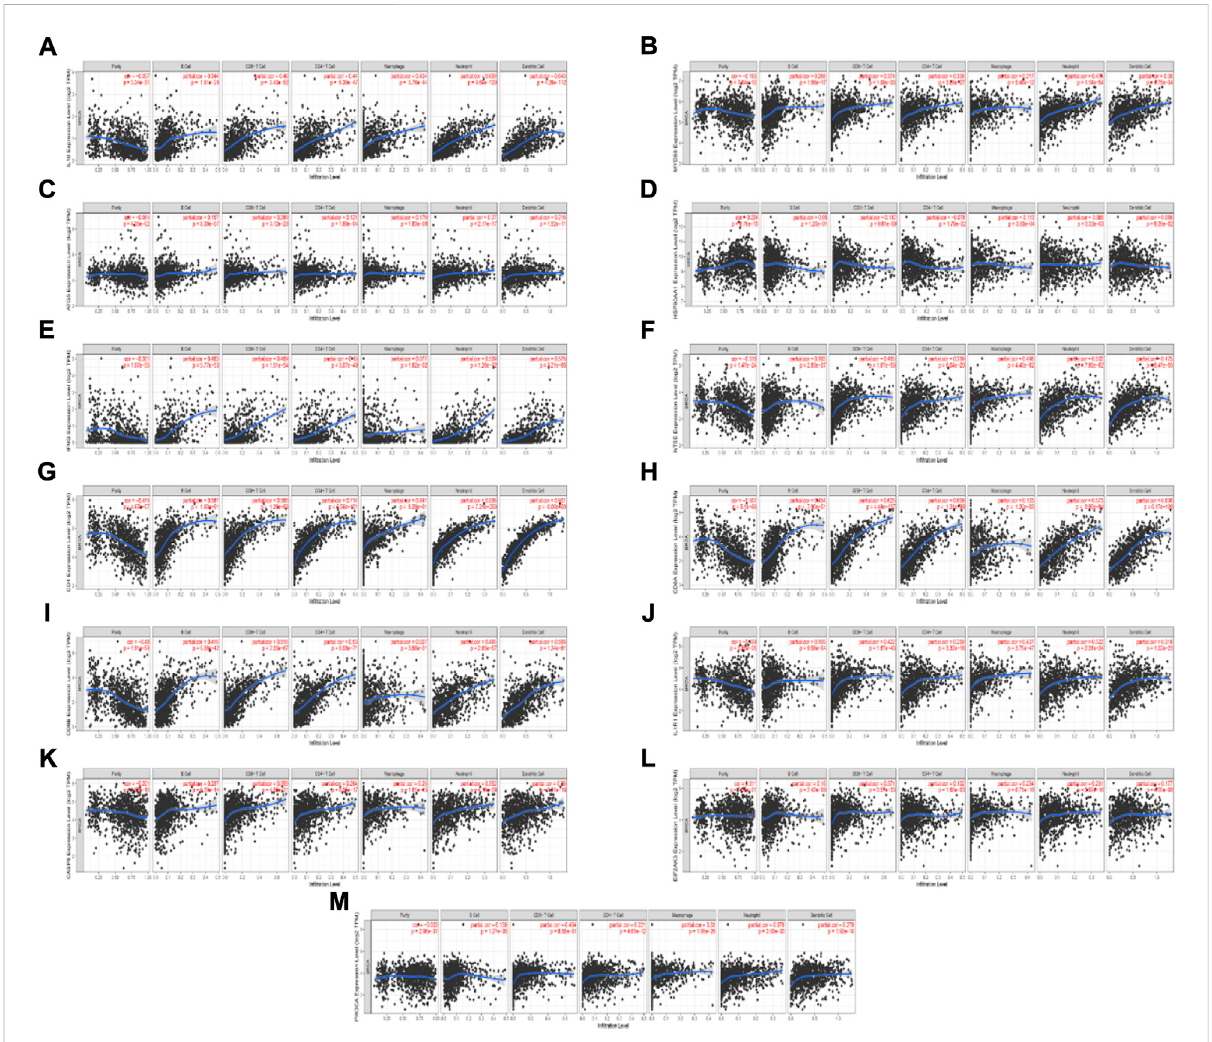
FIGURE 7 Relationship between the ICD-associated mRNAs expression levels and the immune cell in fi ltration level using TIMER. (A – M) IL10, MYD88, ATG5, HSP90AA1, IFNG, NT5E, CD4, CD8A, CD8B, IL1R1, CASP8, EIF2AK3, PIK3CA expression levels and the immune cell in fi ltration